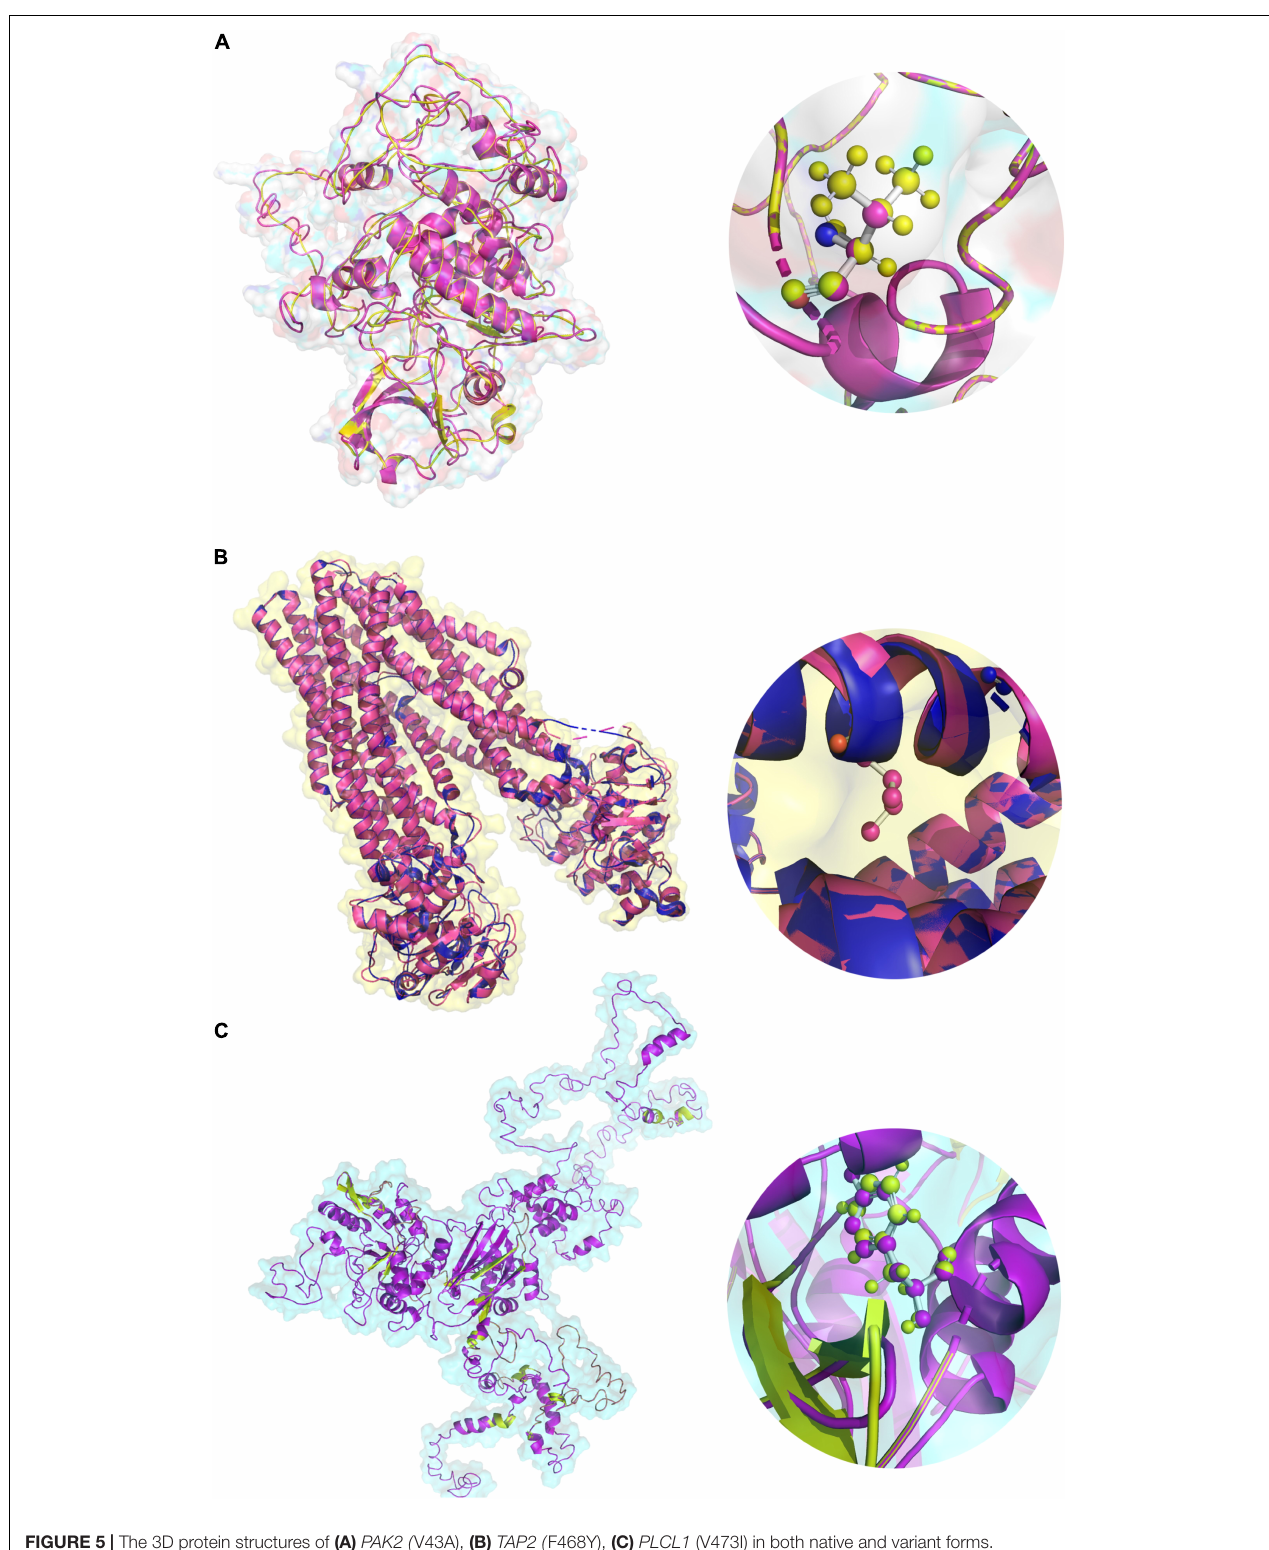
FIGURE 5 | The 3D protein structures of (A) PAK2 ( V43A), (B) TAP2 ( F468Y), (C) PLCL1 (V473I) in both native and variant forms.